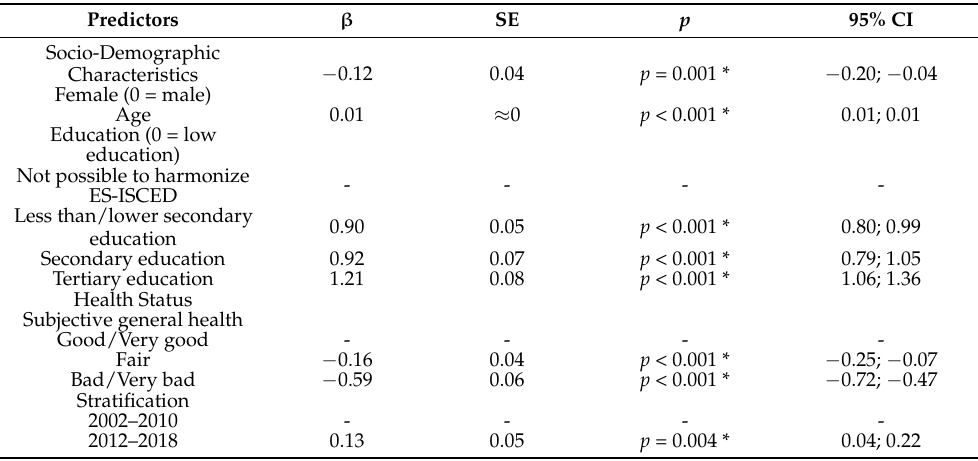
Table 10. Model 5—self-interest adjusted for stratification